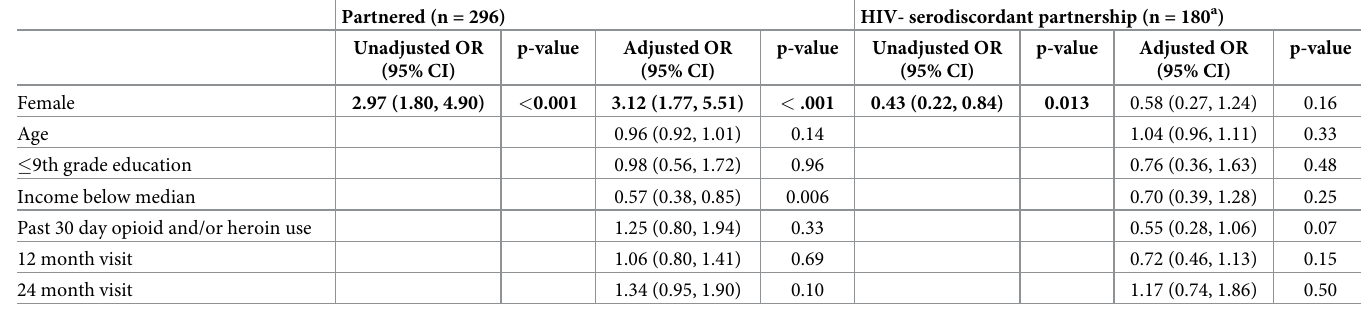
Table 2. Unadjusted and adjusted relative odds for being partnered and being in an HIV-serodiscordant partnership over time in a cohort of PLWH who have ever injected drugs in St. Petersburg, Russia, GEE logistic regression model.